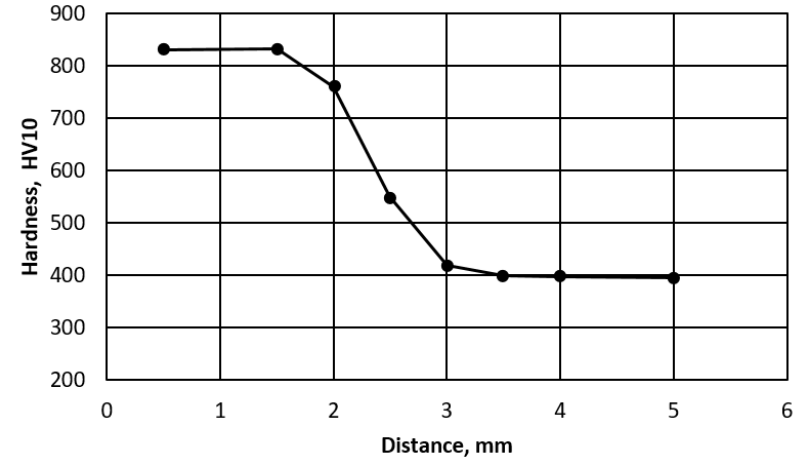
Figure 3. Hardness distribution from the cutting surface.